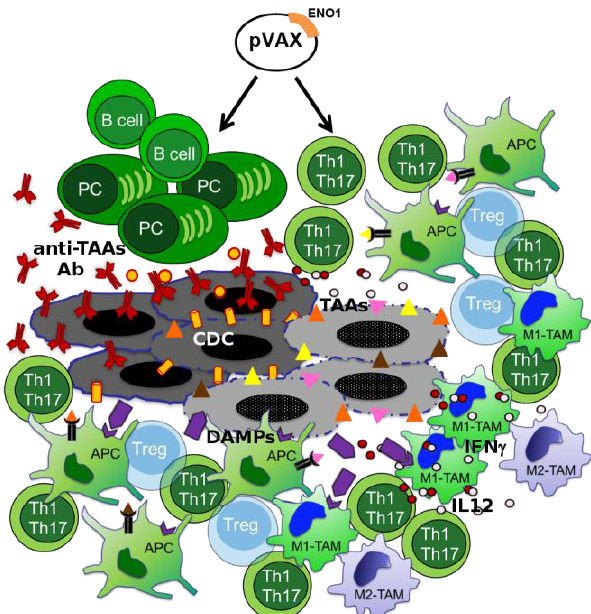
Figure 2. Effects of the ENO1 DNA vaccination and chemotherapy combination. Multiple effects of ENO1 DNA vaccination and chemotherapy (CTX) on innate and adaptive anti-tumor responses are shown. Transparent Tregs represent inhibited cells; triangles, TAAs; violet symbols, damage-associated molecular patterns (DAMPs) and DAMP receptors; antigen presenting cell (APC); tumor associated macrophage (TAM); M1-like phenotype TAM (M1-TAM); M2-like phenotype TAM (M2-TAM).